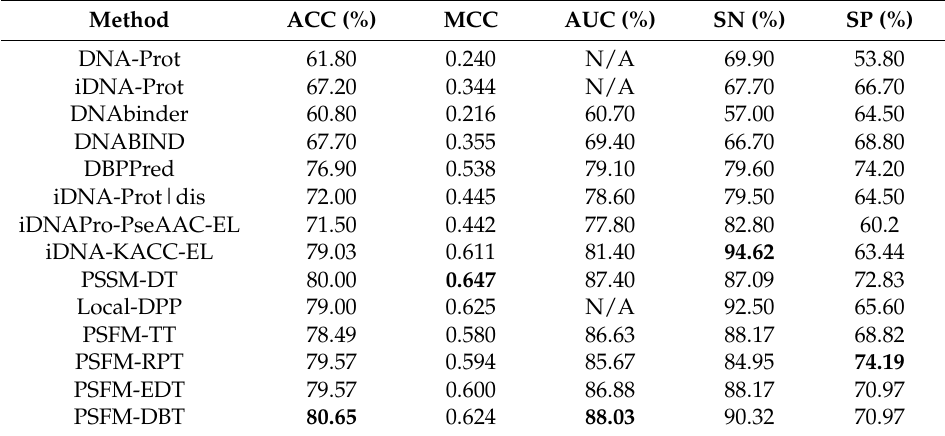
Table 3. Performance of various methods on the independent dataset.